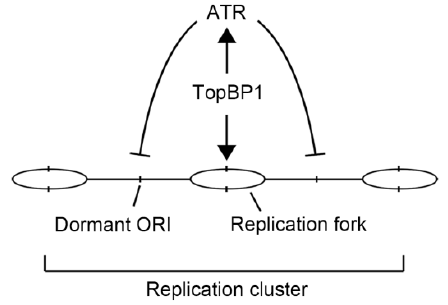
Figure 6. A model for the role of TopBP1 in the S phase. During the S phase, TopBP1 activates the firing of new forks, and the TopBP1 local activation of serine/threonine-protein kinase ATR (ATR) inhibits the firing of nearby dormant origins.